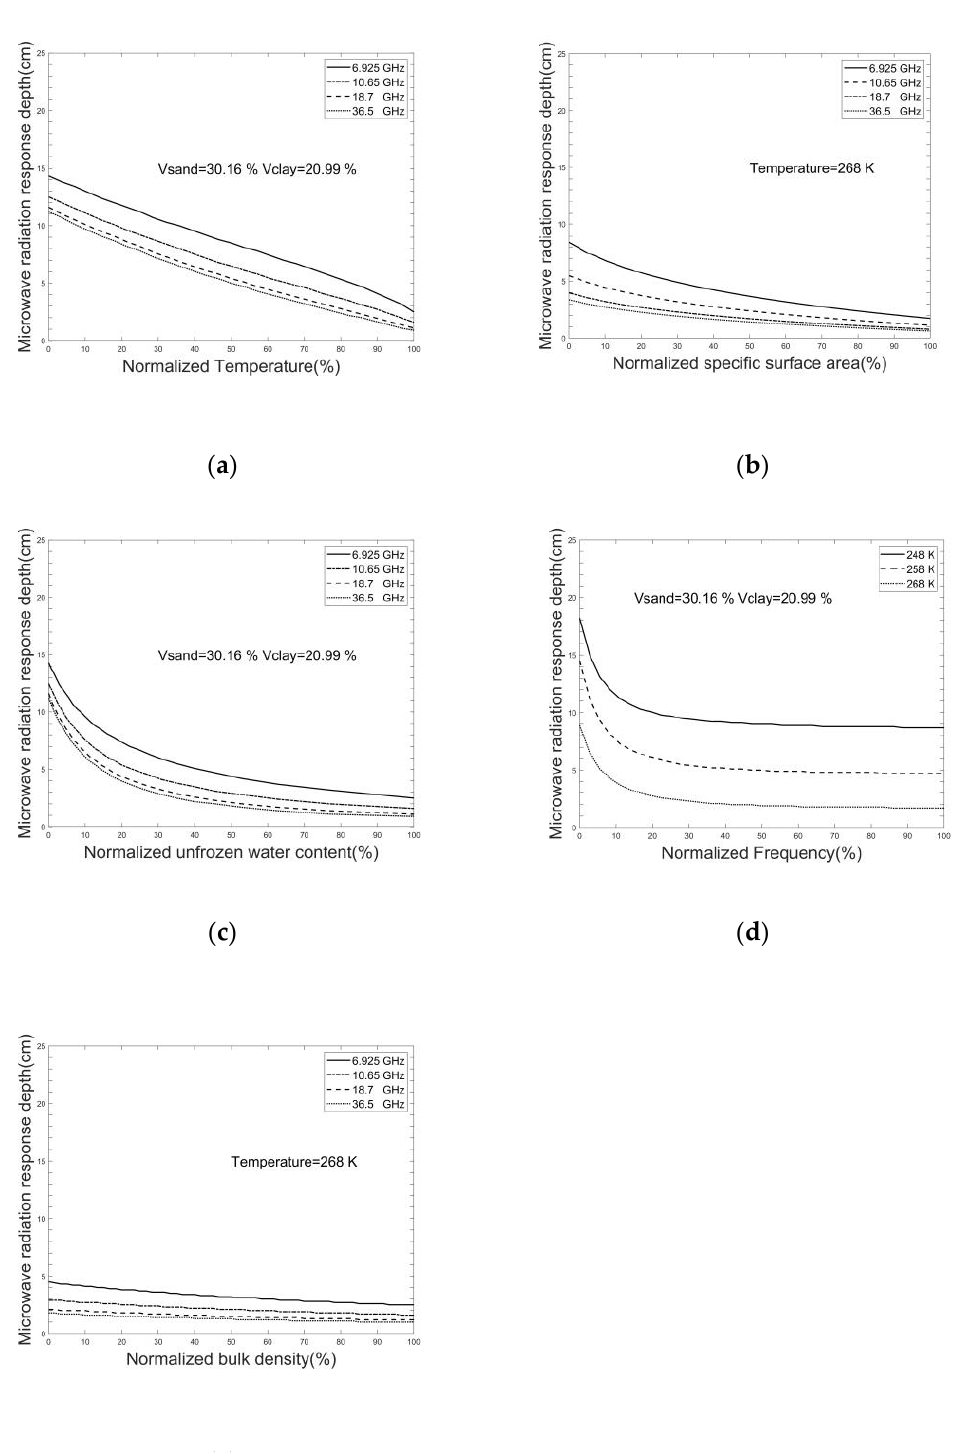
Figure 4. The microwave radiation response depth (MRRD) computed using the theoretical model as a function of normalized soil temperature ( a ), soil specific surface area ( b ), unfrozen soil water content ( c ), frequency ( d ), and bulk density ( e).